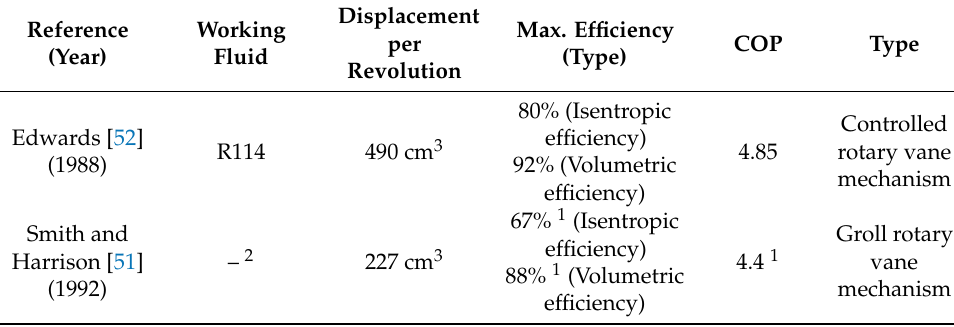
Table 4. Performance of fixed sliding vane